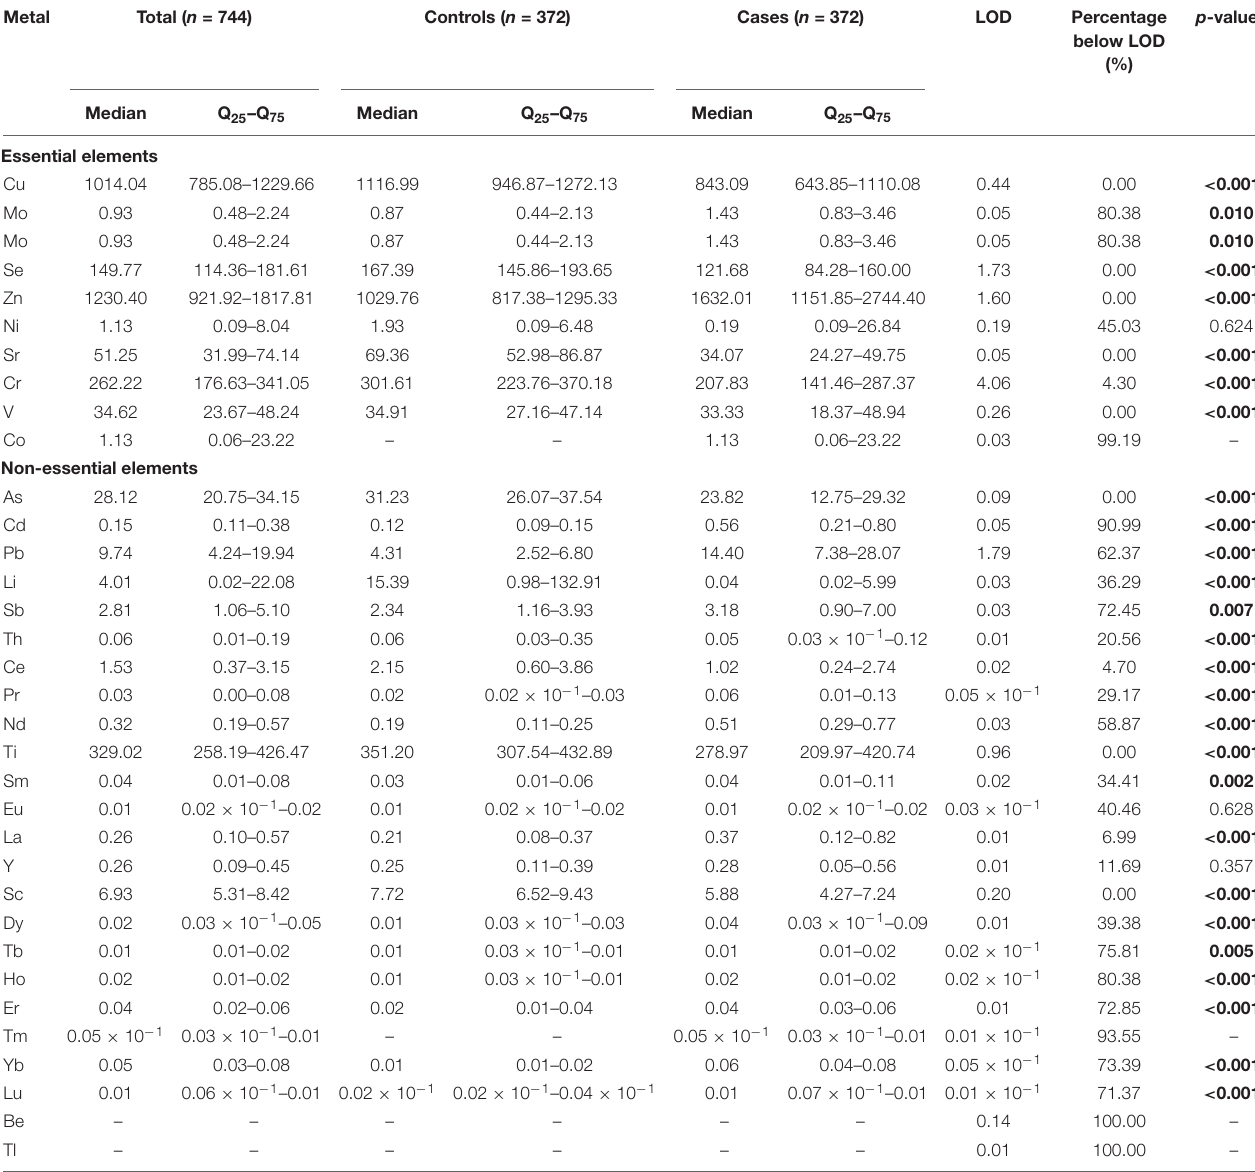
TABLE 2 | Trace metals concentration ( µ g/L) in sera of all